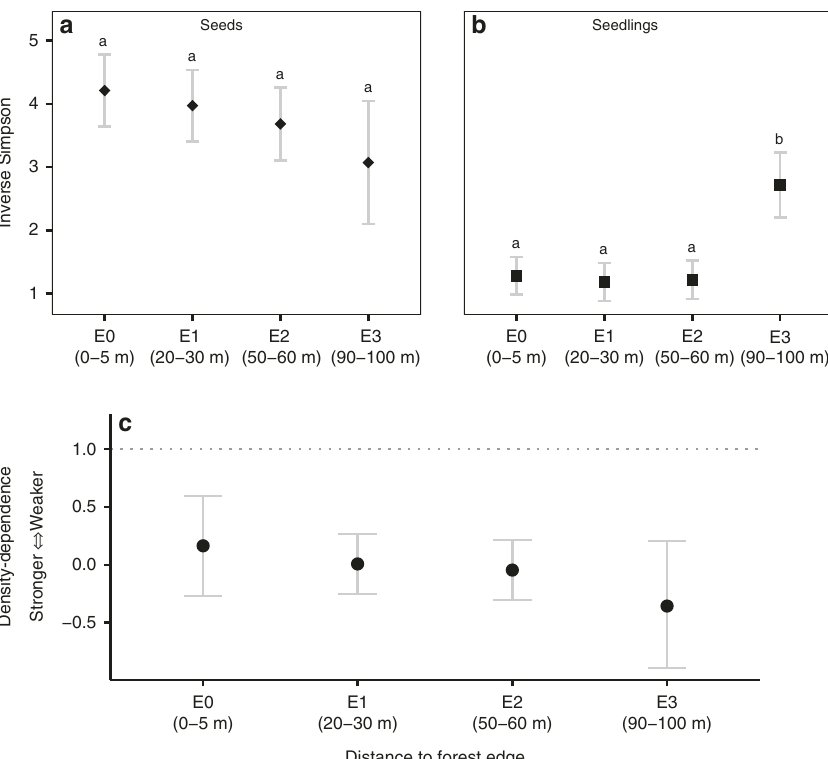
Fig. 2 Variation in seed and seedling diversity and CNDD at different distances from the forest edge. Inverse Simpson diversity of a seeds arriving in seed traps ( N = 146) and b seedlings that recruited into adjacent 1 m 2 control plots ( N = 146) at increasing distances from forest edge. Larger values indicate higher diversity. Points represent mean values per edge-distance and error bars show 95% con fi dence intervals for the means. E0 through E3 represent increasing distances from the forest edge. Letters denote signi fi cant pairwise differences in seed and seedling diversity among edge categories estimated using linear mixed-effects models. Panel c depicts mean strength of conspeci fi c density dependence during seed-to-seedling transition observed in control plots ( N = 146) at increasing distances from the forest edge. Points represent strength of CNDD estimated using hierarchical Bayesian analysis and error bars provide 95% Bayesian credible intervals. Dotted line represents no CNDD (slope =